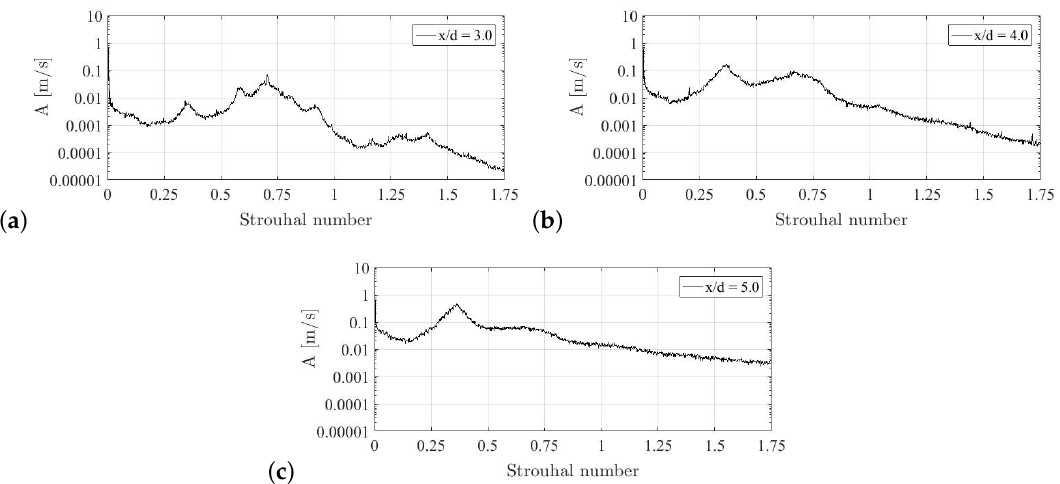
Figure 5. Evolution of spectra of axial velocity fluctuations, S = 0.9, L / D = 7, Re =